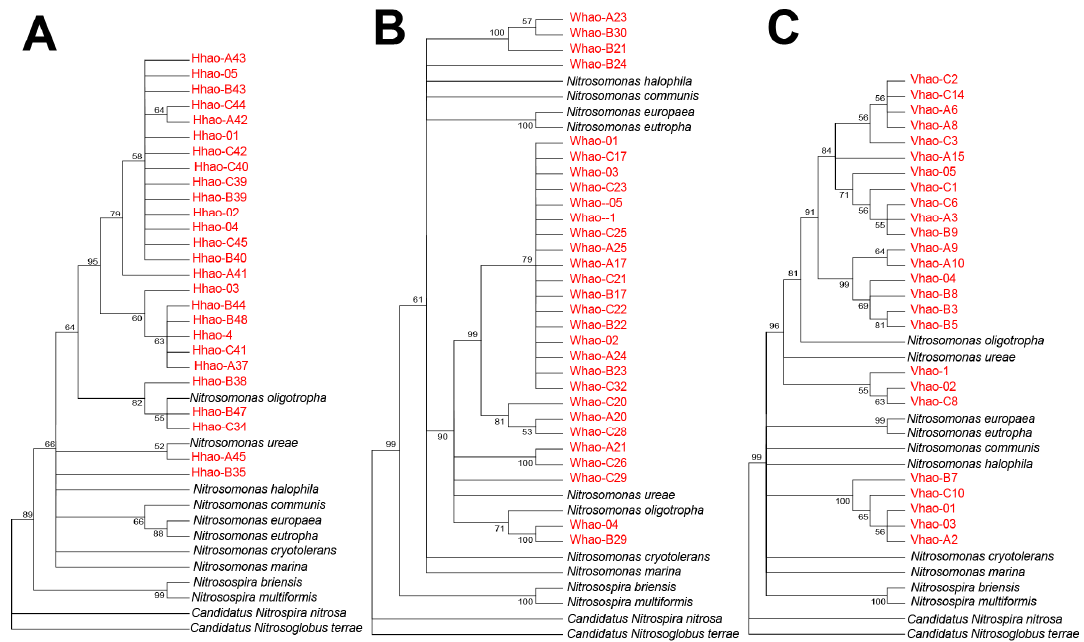
Figure 2. Trees of hydroxylamine oxidoreductase (HAO) constructed based on protein sequences using the neighbor-joining method. Sequences from this study are shown in red ( A ) sample QL-H; ( B ) sample SR-W; ( C ) sample QL-V). Other representative HAO from the protein database and